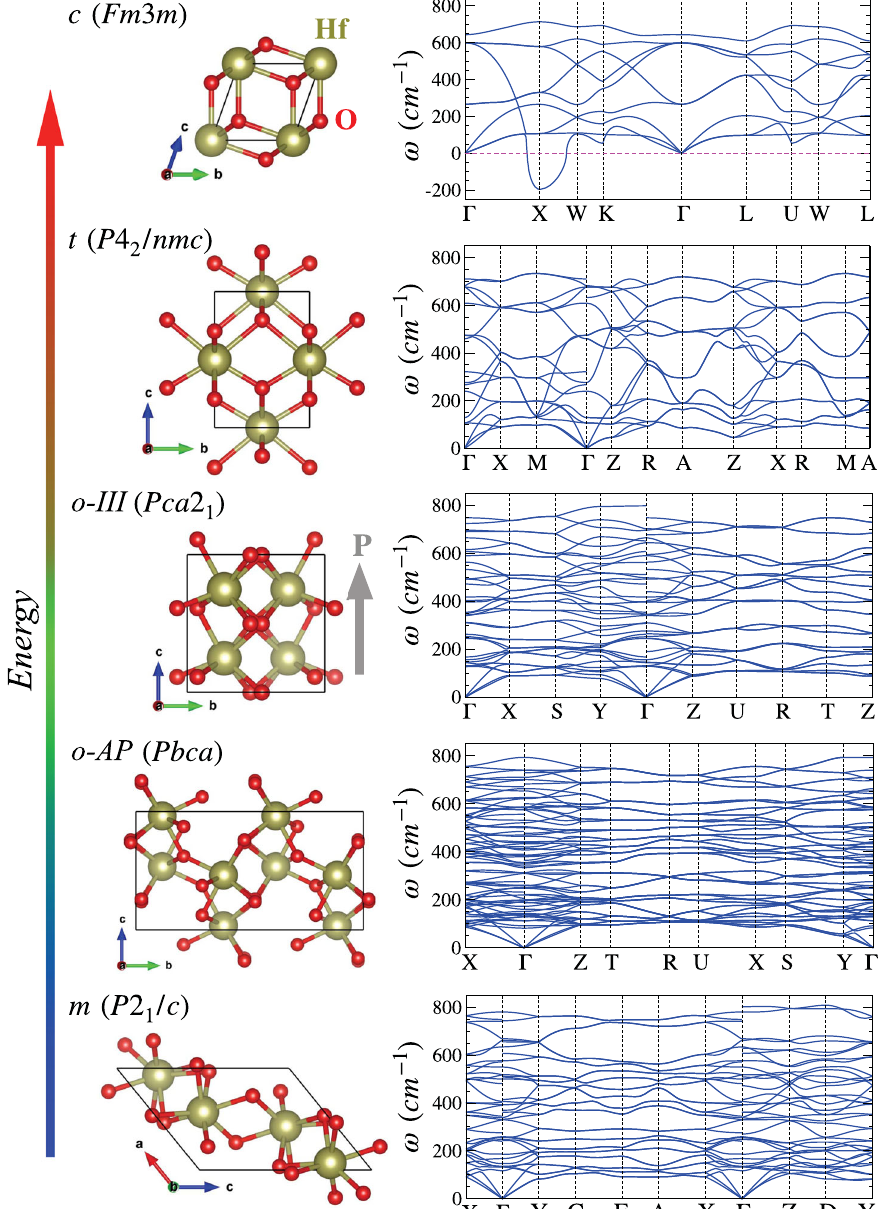
Fig. 1 Crystal structure and calculated phonon dispersions of the fi ve studied phases of bulk HfO 2 . These include: cubic (c), tetragonal (t), orthorhombic polar (o-III), orthorhombic antipolar (o-AP), and monoclinic (m), arranged in the order of increasing formation energy. The c phase has the highest formation energy, whereas the m phase has the lowest formation energy. The gray arrow denotes the direction of the ferroelectric polarization ( P ) in the o-III